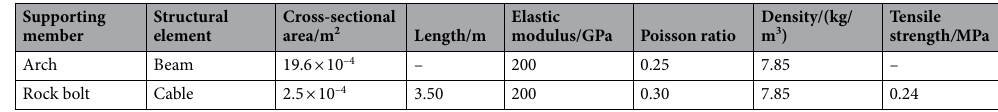
Table 7. Parameters of rock bolt and supporting arch.